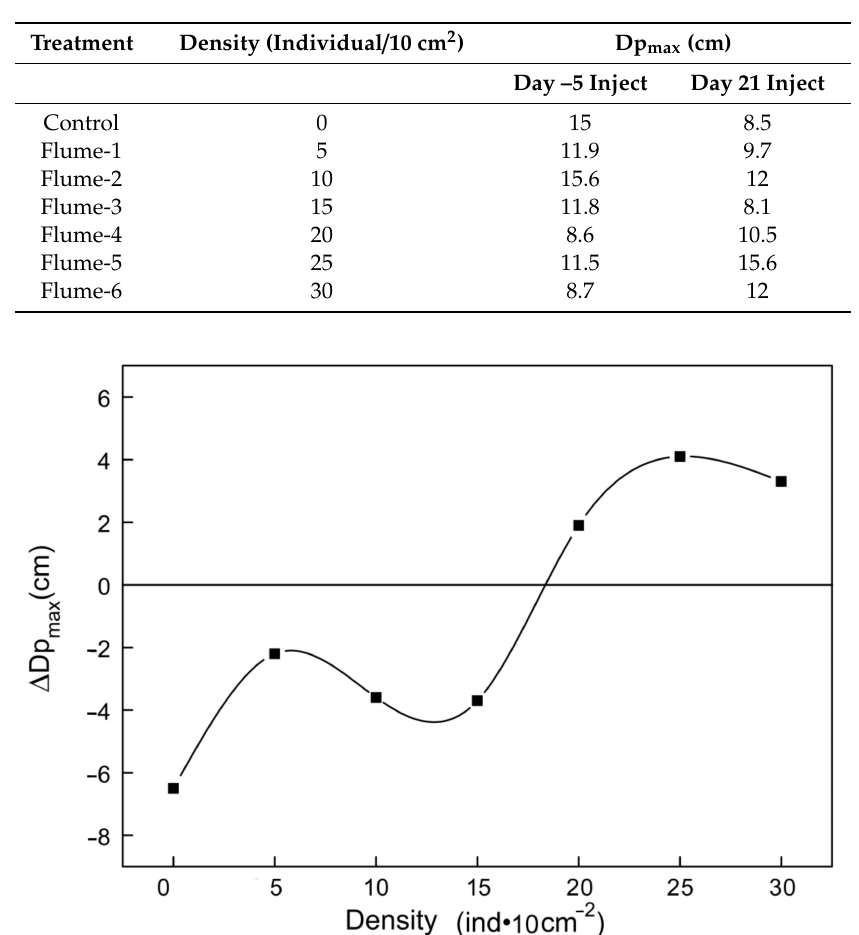
Figure 8. Changes of the Dp max induced by bioturbation under seven biological densities. Its positive or negative corresponds to the increasing or reducing trend compared with the initial Dp max before the introduction of